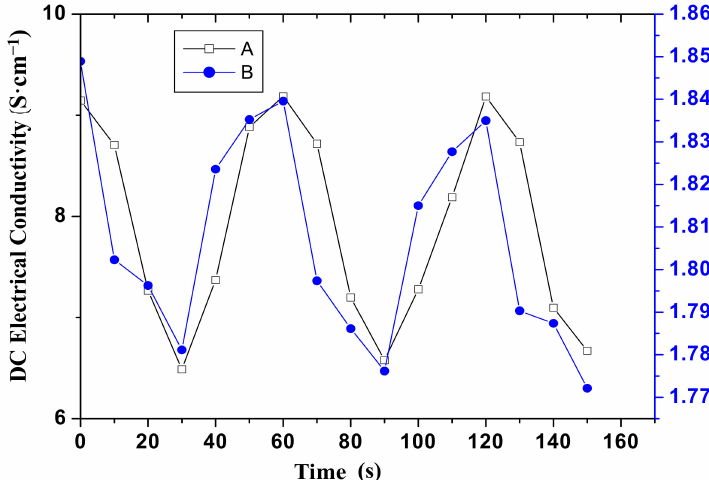
Figure 8. Electrical conductivity of curve A PPy / MoS 2 nanocomposite and curve B PPy upon alternate exposure to 1000 ppm of ammonia vapors and air with respect to